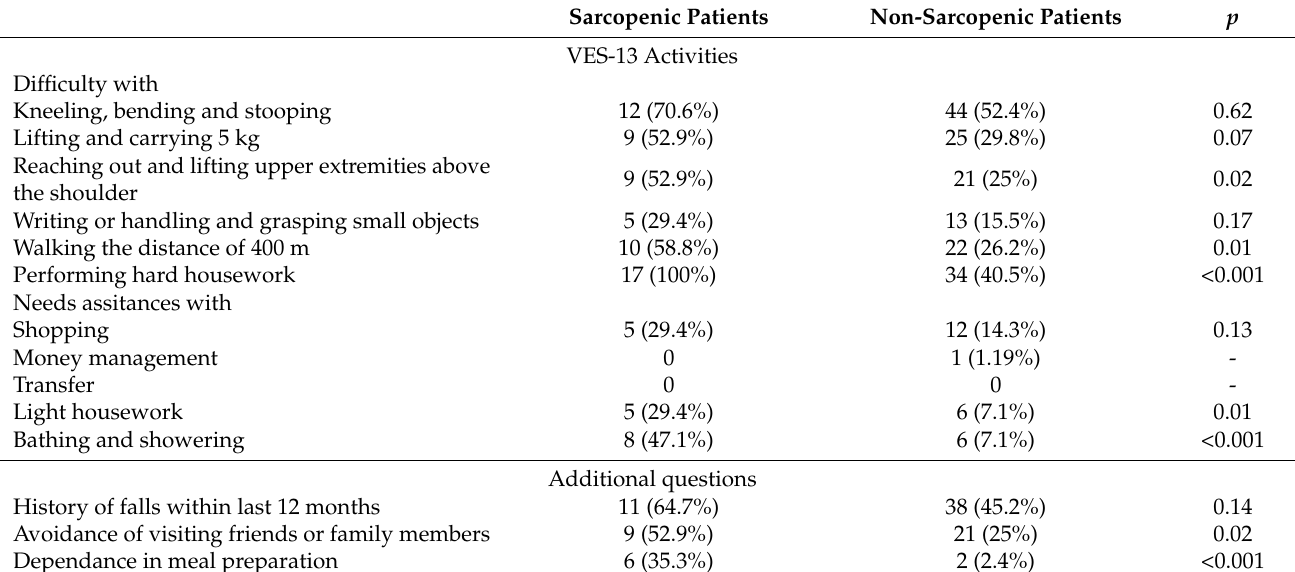
Table 4. Comparison of functional status between sarcopenic and non-sarcopenic patients.